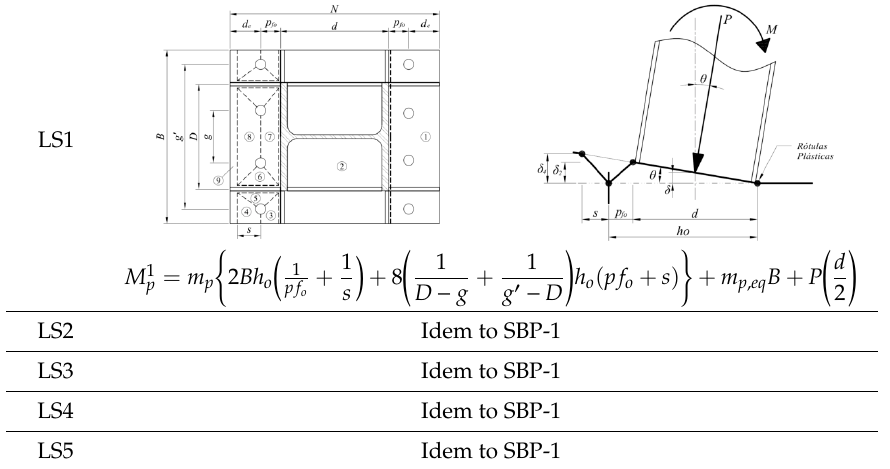
Table 5. Limit states that control the design of base plate type SBP-2.